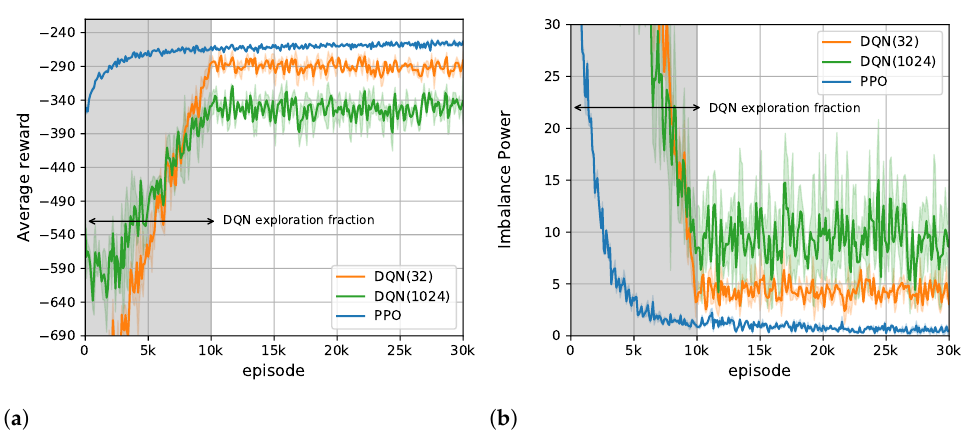
Figure 4. Training performance of DQN and the proposed approach (PPO). ( a ) Mean and 95% confidence interval of episode rewards over five random runs; ( b ) Mean and 95% confidence interval of imbalance power over five random runs.